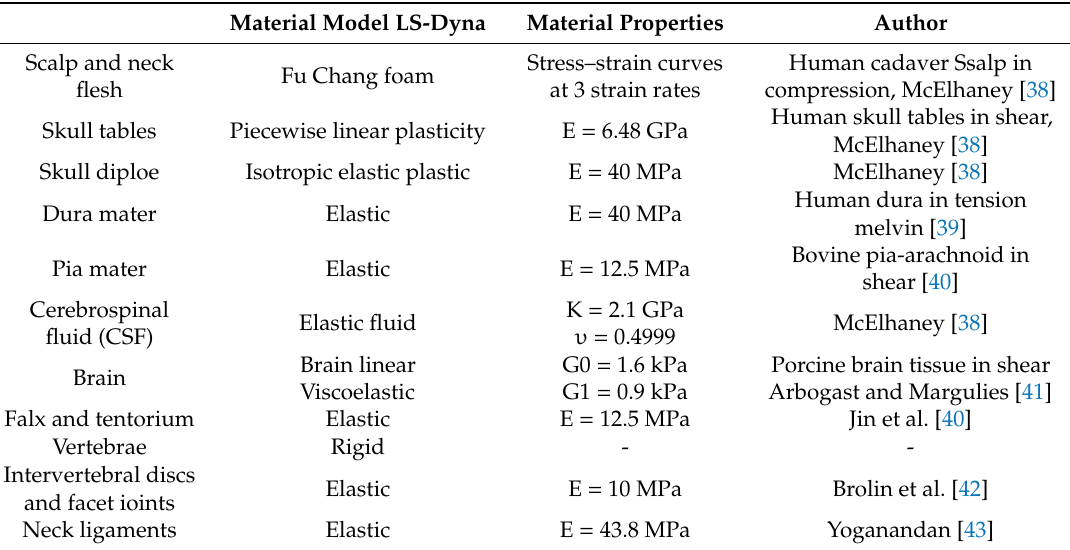
Figure 4. Human head model (6.47 kg mass). Table 3. Human head mechanical